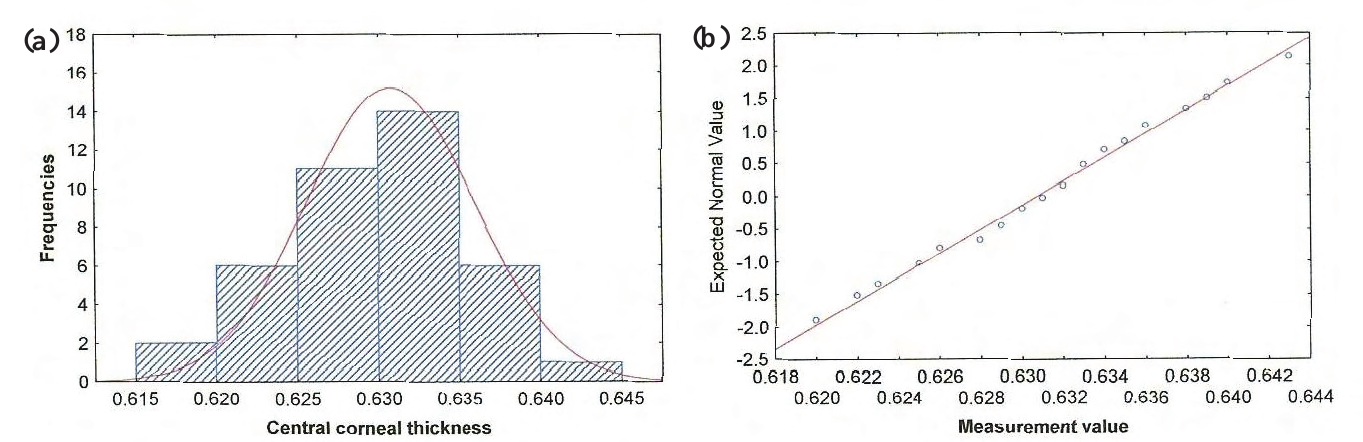
Figure 6. A histogram (a) and normal probability plot (b) for the CCT sample of subject 1. The histogram shows the frequency dis- tribution for the CCT measurements. The bars show the specific values of measurements that occur most frequently in the sample. The curve in red indicates the normal distribution and normality of the sample is also tested using the Kolmogorov-Smirnov (K-S), Lilliefors and Shapiro-Wilks tests. The data showed a normal distribution ( p > 0.05). (SW-W, p = 0.8). The graph (a) helps to evalu- ate the normality of the sample because it also shows the normal curve superimposed over the histogram. The normal probability plot (b) provides a quick way to visually inspect to what extent the pattern of measurements concurs with a normal distribution. The measurements (blue circles) on this plot form a linear pattern near the line in red, which indicates that the normal distribution is a good model for the data sample concerned. Notice also in Table 1 that skewness and kurtosis were almost zero for this sample.